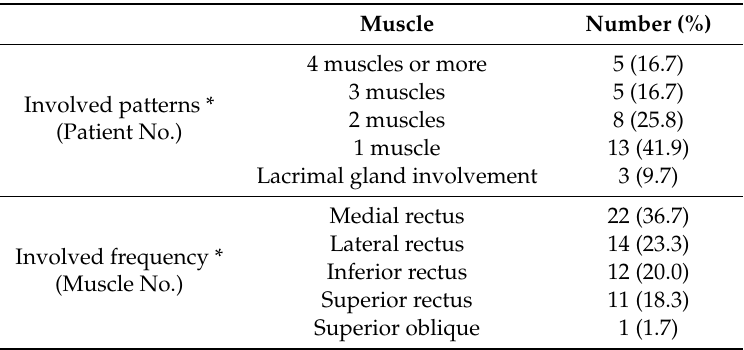
Table 1. The characteristics of muscle